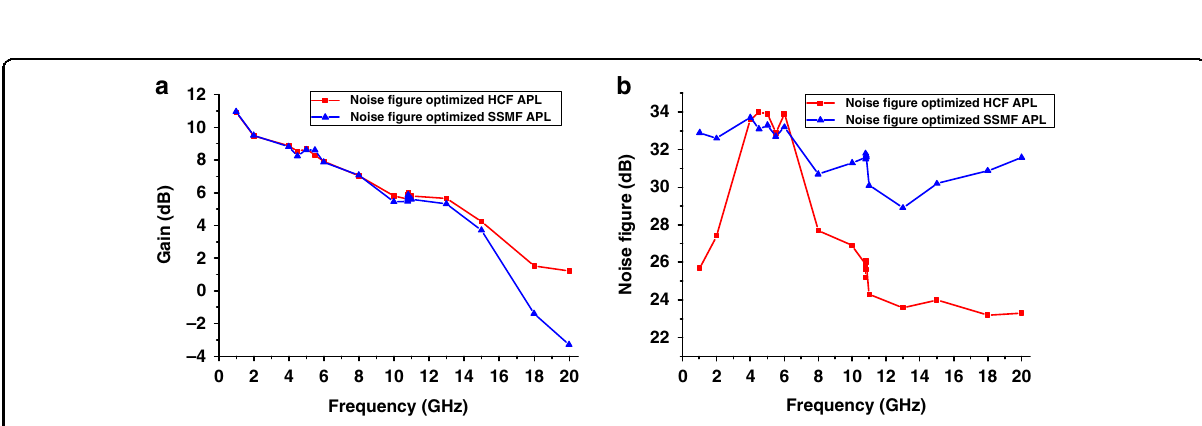
Fig. 7 Measured APL performance in terms of gain and noise fi gure of the noise fi gure optimized APLs. a Gain of noise fi gure optimized SSMF (triangle symbols) and HCF (square symbols) APLs versus RF input frequency. Gain reduction at higher frequencies is mainly due to the limited bandwidth of the MZM and PD. b Corresponding noise fi gures. At 4 – 7 GHz range, HCF APL noise fi gure is limited by the signalling laser RIN due to its relaxation fi gure optimized SSMF APL (gain and noise fi gure shown